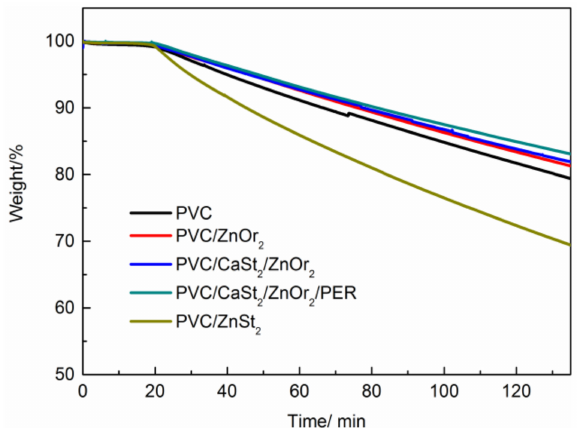
Figure 16. The TGA curves of pure PVC and PVC stabilized with various complex thermal stabilizers with keeping 220 ◦ C for 2